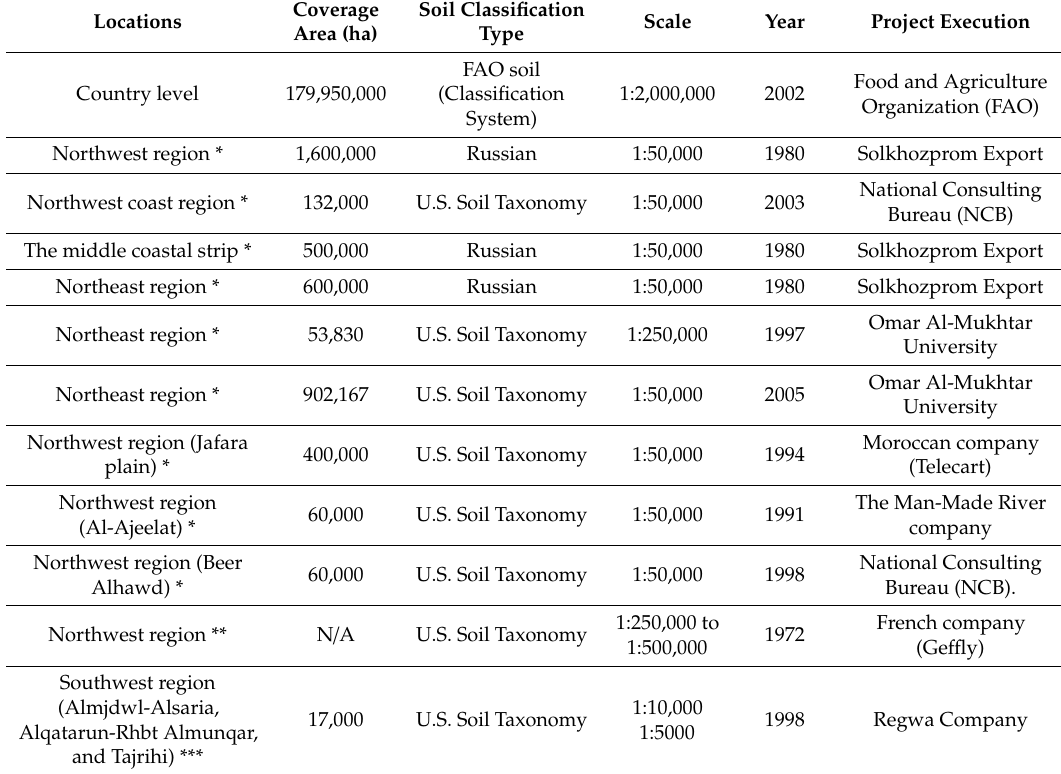
Table 4. Description of soil databases available for ecosystem services studies.